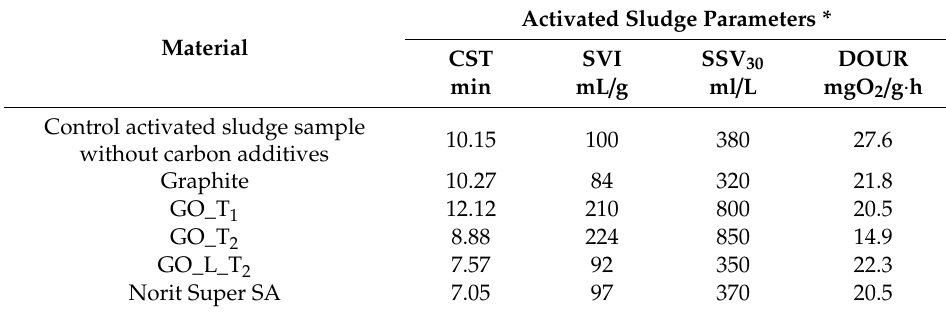
Table 4. Selected parameter values of activated sludge after 24 h reaction with carbon materials (dose 0.5 g / L).